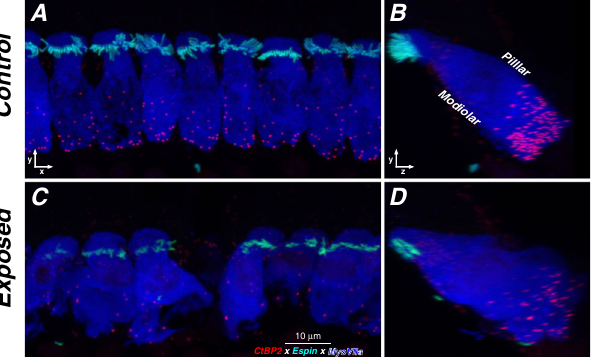
Figure 6. Some exposed ears showed striking loss of synaptic ribbons (CtBP2-red) in localized regions. ( A , C ) Confocal z-stacks from the 16 kHz region of a control and an exposed ear, 1 wk post blast, shown as maximum projections in the acquisition plane (xy). ( B , D ) The same z-stacks reprojected into the zy plane. The exposed ear also shows stereocilia damage (espin - cyan) and disruption of the normal modiolar-pillar gradient in ribbon size, which is normally correlated with the gradient of spontaneous rate and threshold in auditory-nerve fibers 28 .